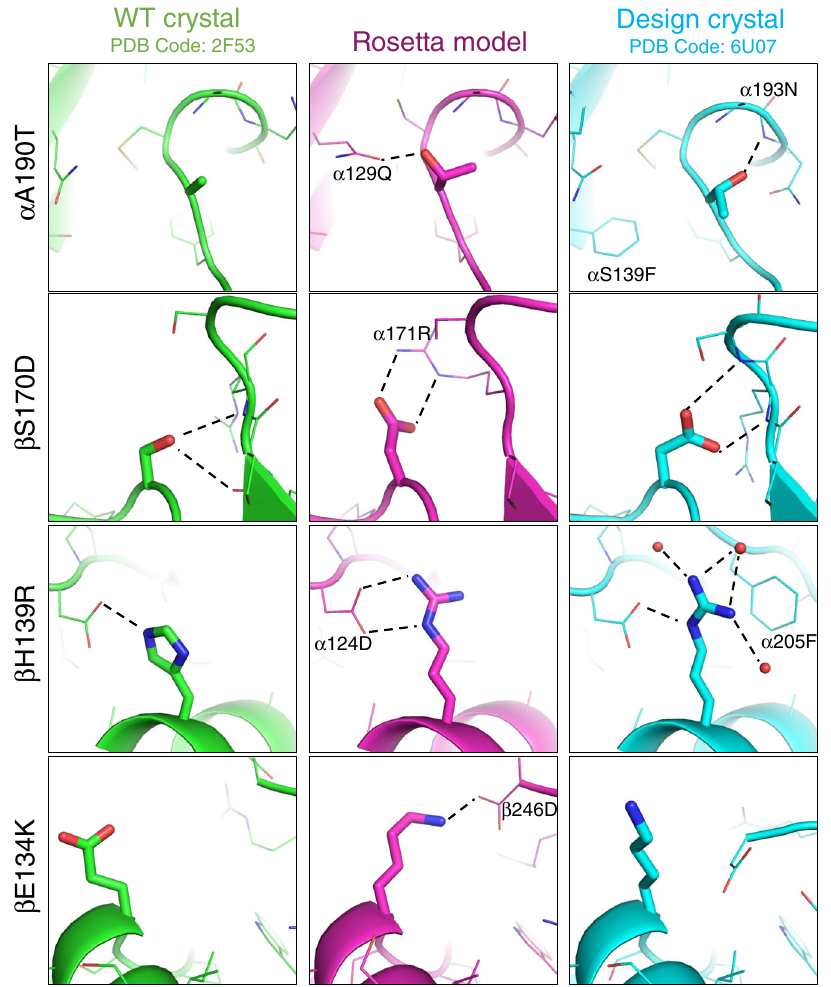
Fig. 3 Structural characterization of mutations to polar amino acids. The wild-type crystal structure (pdb: 2F53, energy minimized with Rosetta) is shown in green, The Rosetta models for the mutations is shown in magenta, and the crystal structure of the stabilized TCR C α /C β (pdb: 6U07) with the seven stabilizing mutations is shown in